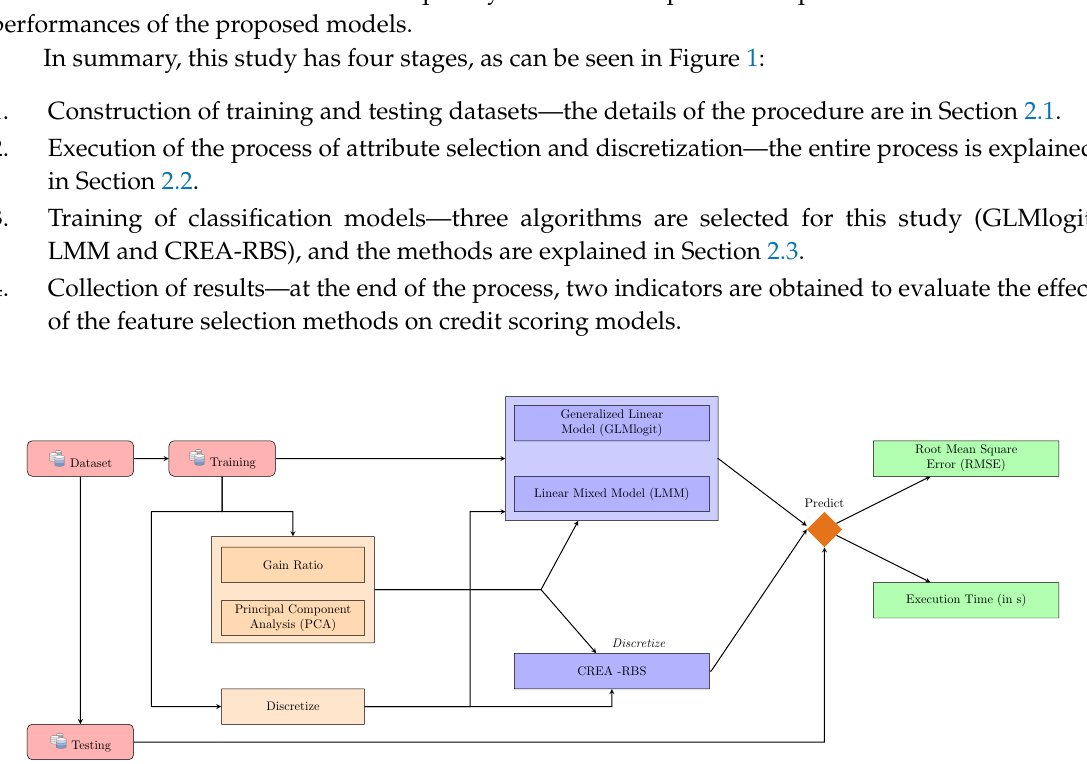
Figure 1. Summary of study. CREA-RBS, classification rules extraction algorithm-reduction based on